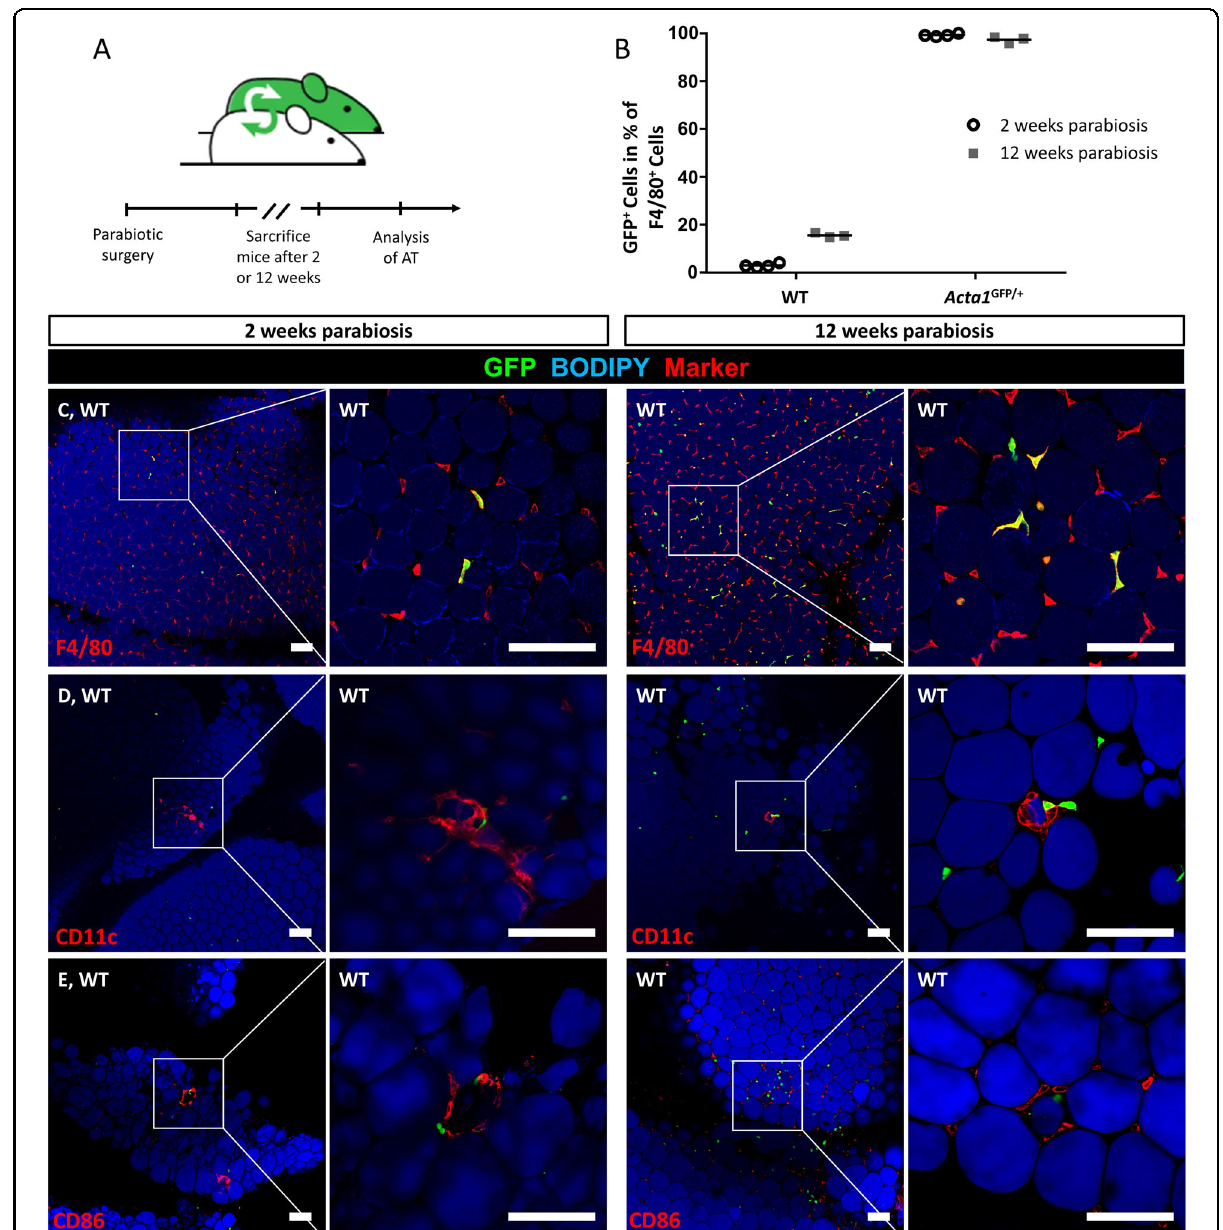
Fig. 7 CLS formation does not involve monocyte recruitment in vivo. A Timeline of parabiosis experiments. B Quanti fi cation of GFP + F4/80 +